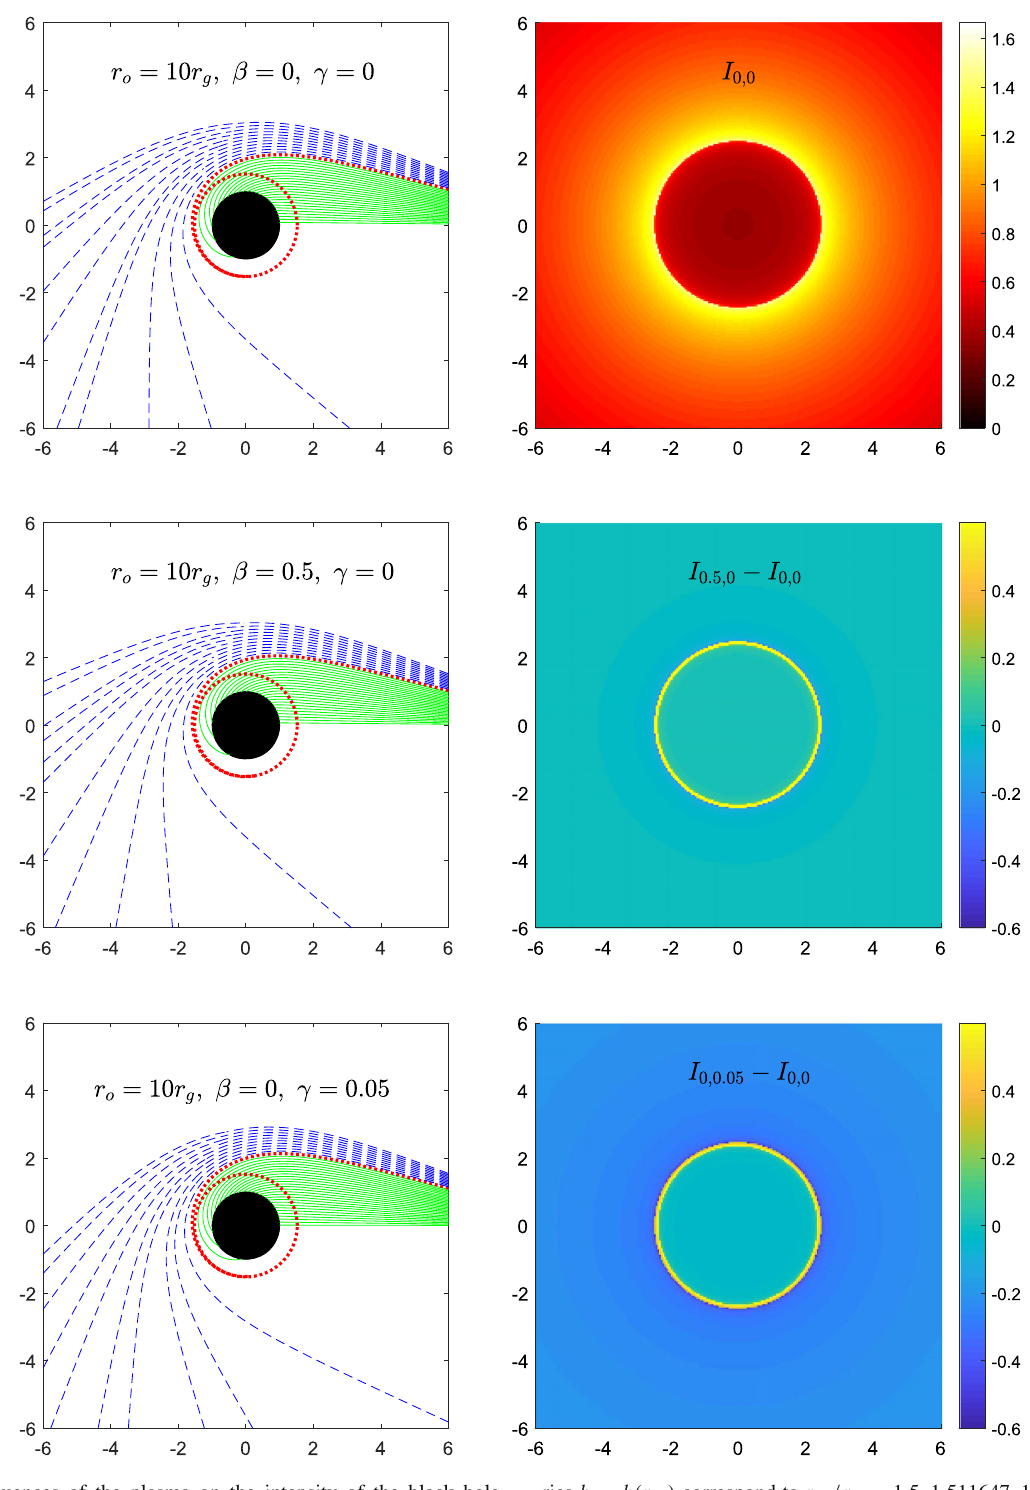
ries b = h ( r ph ) correspond to r ph / r g = 1 . 5 , 1 . 511647 , 1 . 493443 and h ( r ph )/ r g = 2 . 598076 , 2 . 477186 , 2 . 714083 in turn. Right panels: the observedintensityimagefor r o = 10 r g , β = 0, γ = 0 (topright)andits differences with images for β = 0 . 5, γ = 0 (middle right) and β = 0, γ = 0 . 05 (bottom right). All Axes are rescaled by r